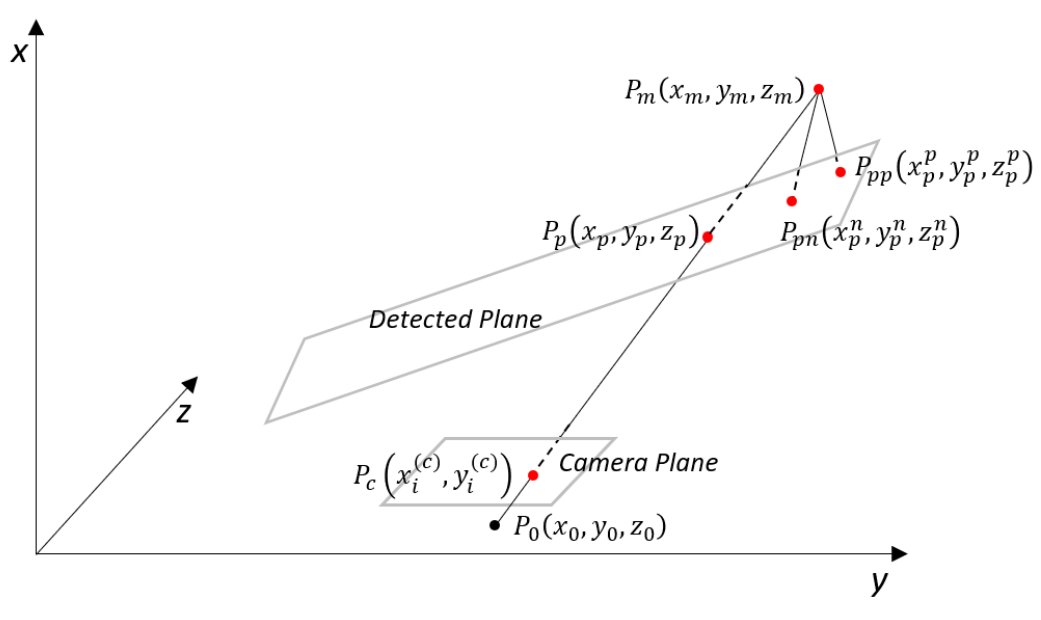
Figure 5. Illustration of the o ff set calculation. P m P pp is the o ff set in the perpendicular direction, P m P pn is the o ff set in the camera plane normal direction, and P m P p is the o ff set in the radial direction.